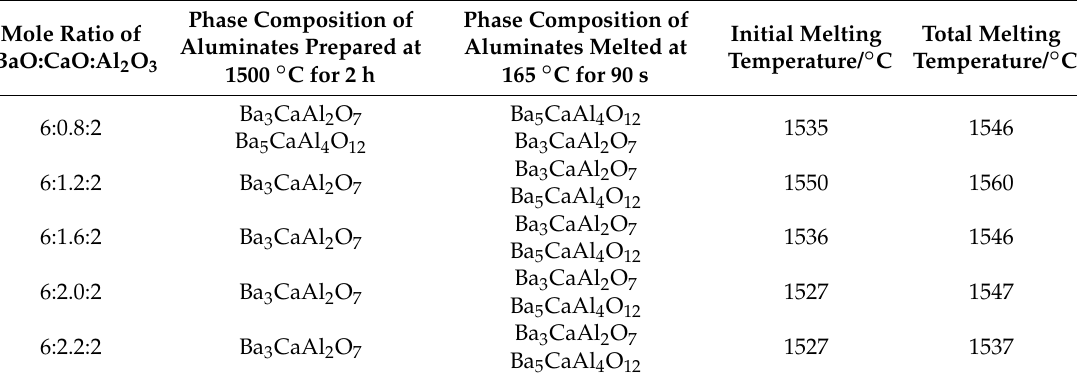
Table 1. Properties of 6BaO · xCaO · 2Al 2 O 3